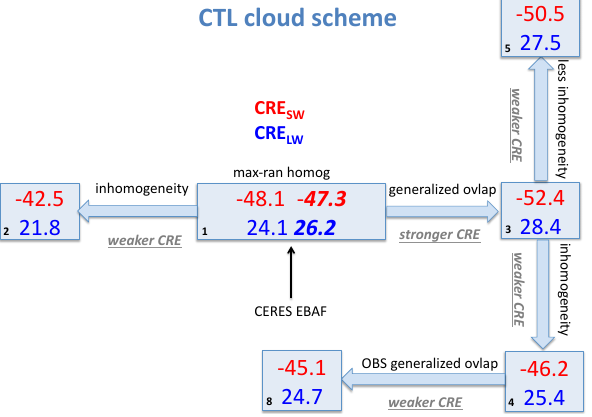
Fig. 2. Box chart providing diagnostic CRE in Wm − 2 (blue for CRE LW , red for CRE SW ) for GEOS-5 CTL scheme experiments with the RRTMG radiation package where cloud condensate dis- tributions change from homogeneous to heterogeneous and over- lap changes from maximum-random to generalized. The numbers in italics in the center box are observed values from the CERES EBAF data set. The numbers in the left bottom corner of the boxes are the experiment IDs according to Table 2.